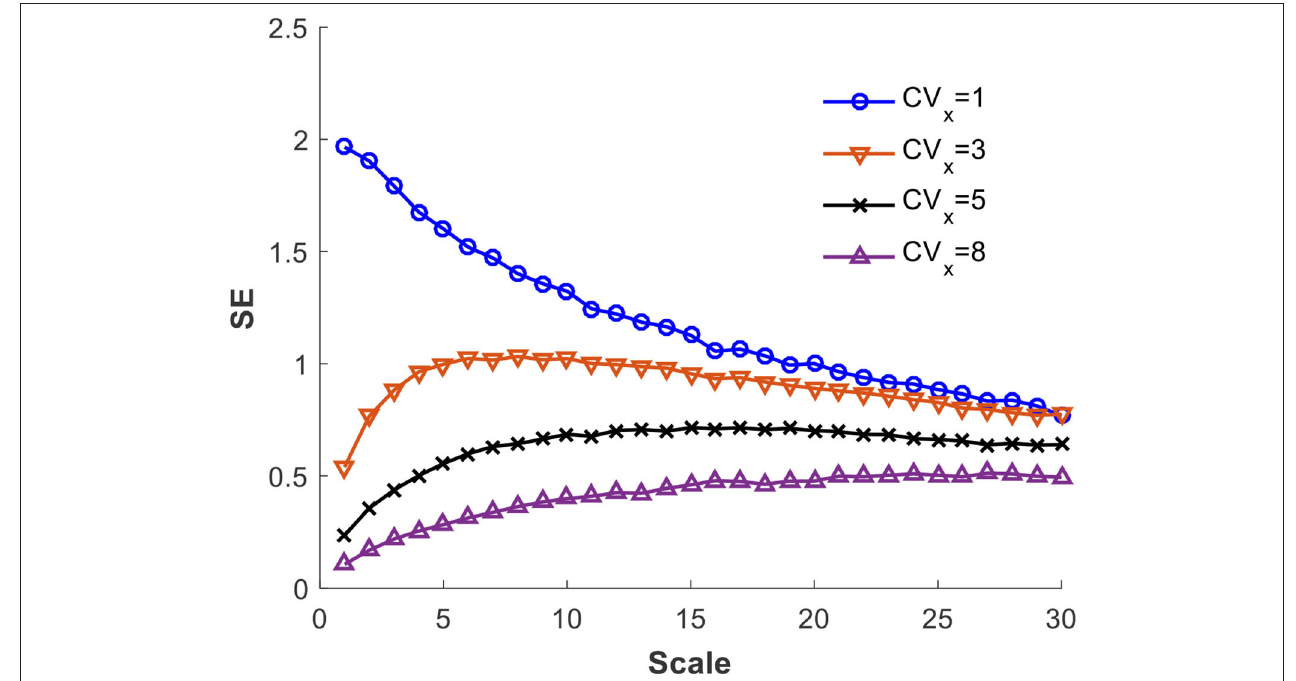
FIGURE 7 | MSE patterns versus CV X of simulated gamma distributed time series with µ X